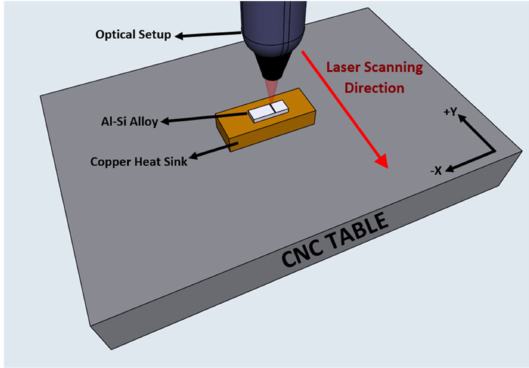
Figure 1. Schematic of the experiment